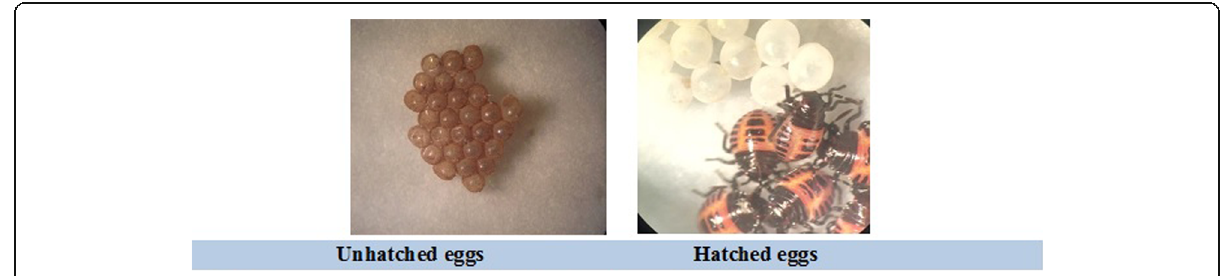
Fig. 3 Appearance of the unhatched and hatched eggs after 264